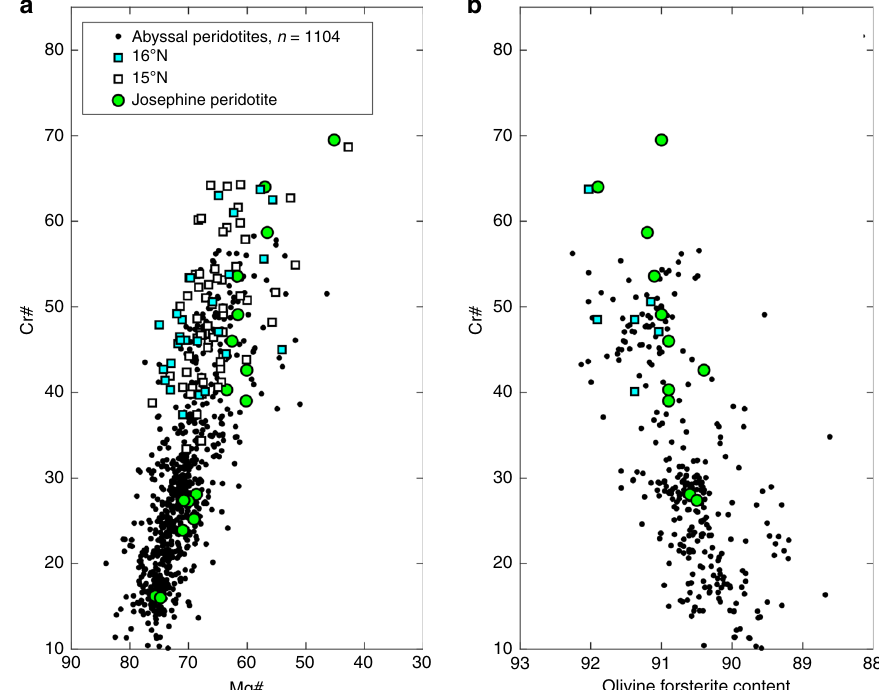
Fig. 3 Chromian spinel and olivine compositions of 14 – 16°N peridotites compared to abyssal peridotites. a Cr# after Dick et al. 40 . b Spinel Cr# plotted against coexisting olivine forsterite content. Josephine peridotite, a well-known SSZ locality, plotted for comparison with data from Le Roux et al. 39 . Abyssal peridotite data from the compilation of Warren 42 . Not all spinel – olivine pairs were analyzed due to alteration. Analytical uncertainties smaller than